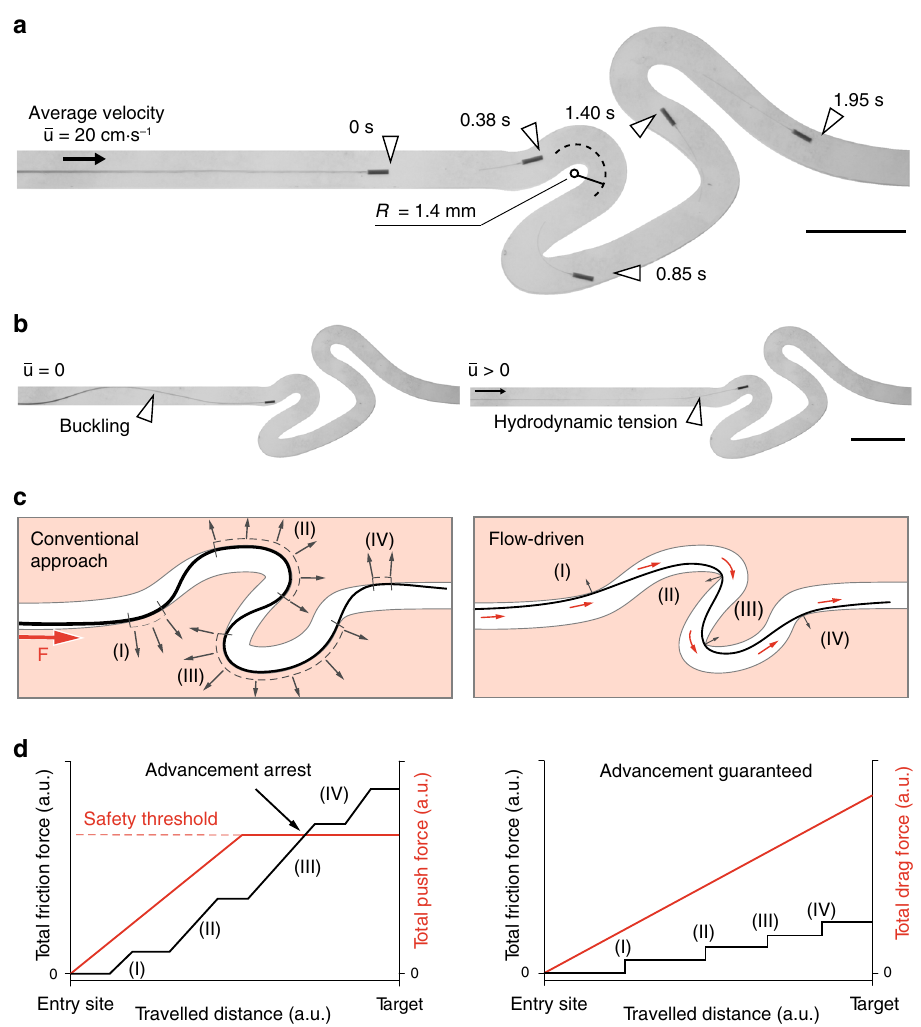
Fig. 2 Characterization of the fl ow-driven autonomous advancement of µ -probes. a Slender μ -probes are transported by the fl ow inside tortuous channels with high curvature at a forward average velocity of 2.8 cm ⋅ s − 1 . The average fl ow velocity is given by (cid:1) u and R denotes the radius of curvature. R in the second and third turns are 1.2 and 1.8 mm, respectively. b In the absence of fl ow, pushing the µ -probe forward generates mechanical instabilities and the advancement ceases (left). Upon introduction of the fl ow, the μ -probe re-engages with it and continues to advance inside the channel. c A comparison between the conventional catheter advancement approach and fl uid-driven transport introduced in this work. The conventional approach relies on a fi nite proximal force, F , and the contact pressure exerted on the outward wall (grey arrows) to transmit forces distally (left). Our approach relies instead on the tensile forces applied by the viscous stresses along the entire structure (right). Small red arrows represent drag forces. Drawings and forces not to scale. d In conventional navigation paradigm, friction forces increase with the length of the fi lament. The externally applied push force must be increased accordingly to be able to maintain the advancement. However, input forces above a safety threshold may result in vessel perforation or dissection. Ultimately, when the friction exceeds the push force, the intervention reaches its limit. On the other hand, in our approach, the continuous presence of hydrodynamic forces maintains tension on the structure and warrants a positive difference between the drag force and the friction, regardless of the travelled distance. Plots are conceptual. Scale bars, 5